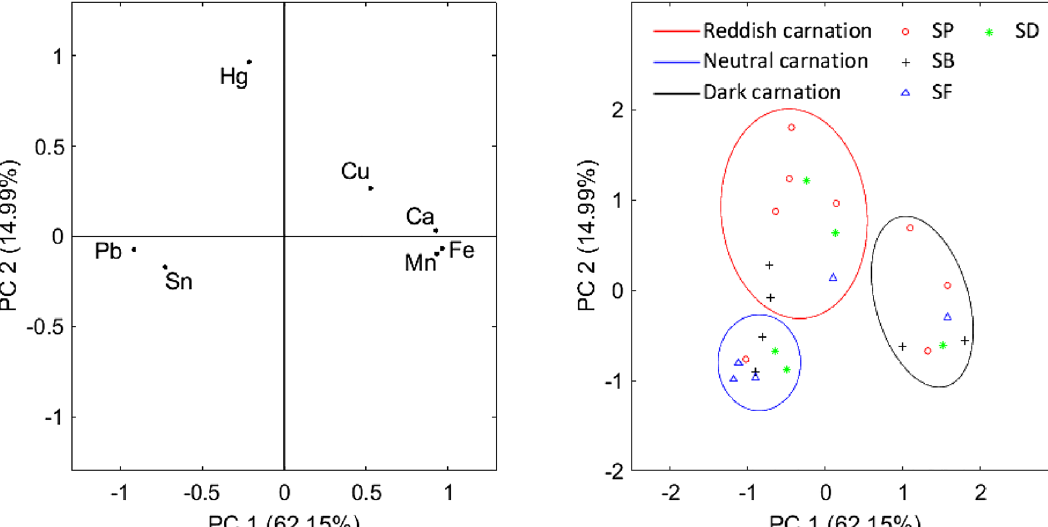
Figure 7. PCA scores (left) and results of the PCA analysis applied to the pigments of the skin tones of the four paintings (right). Three groups are identified based on the tonality of the pigments: neutral skin tone (blue), dark skin tone (black), and reddish skin tone